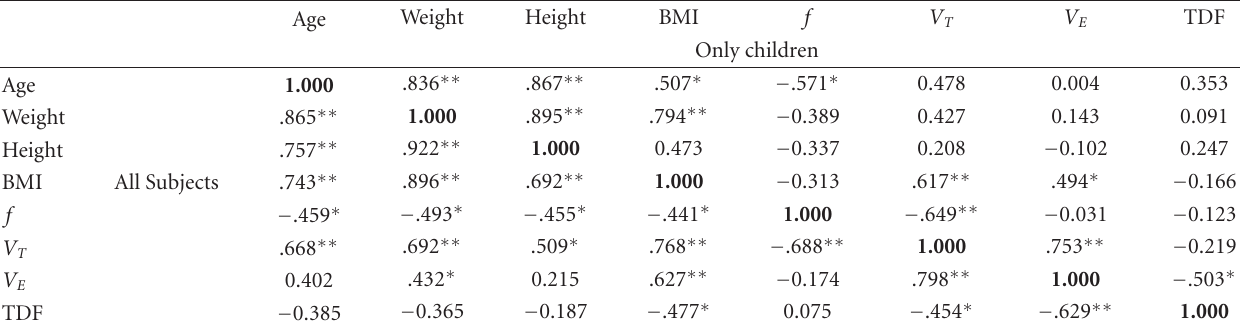
Table 4: Pearson correlation coe ffi cients for variables.